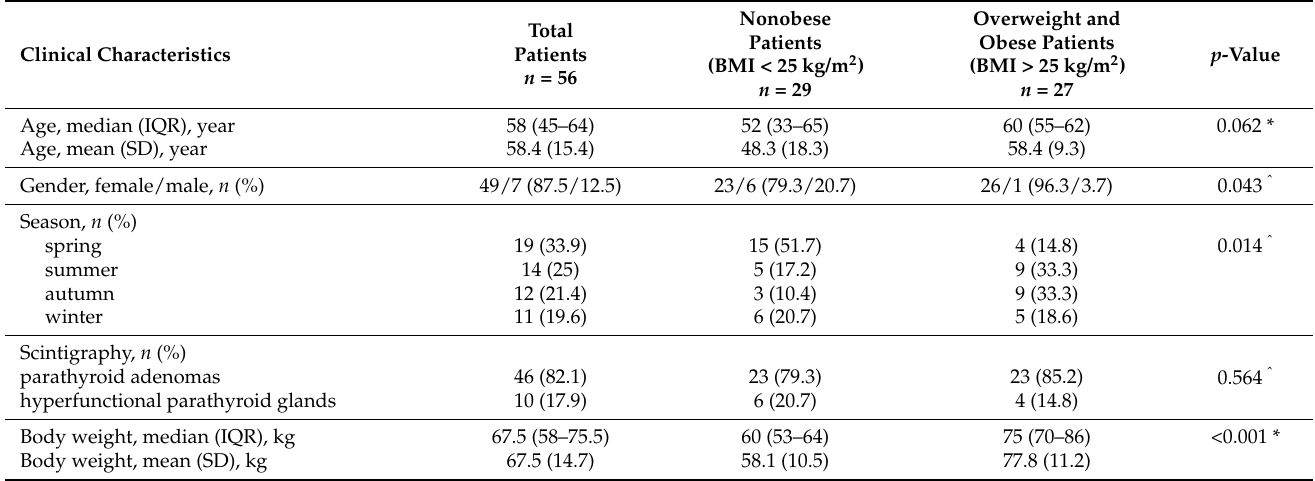
Table 1. The demographic/clinical characteristics of patients with active BAT.